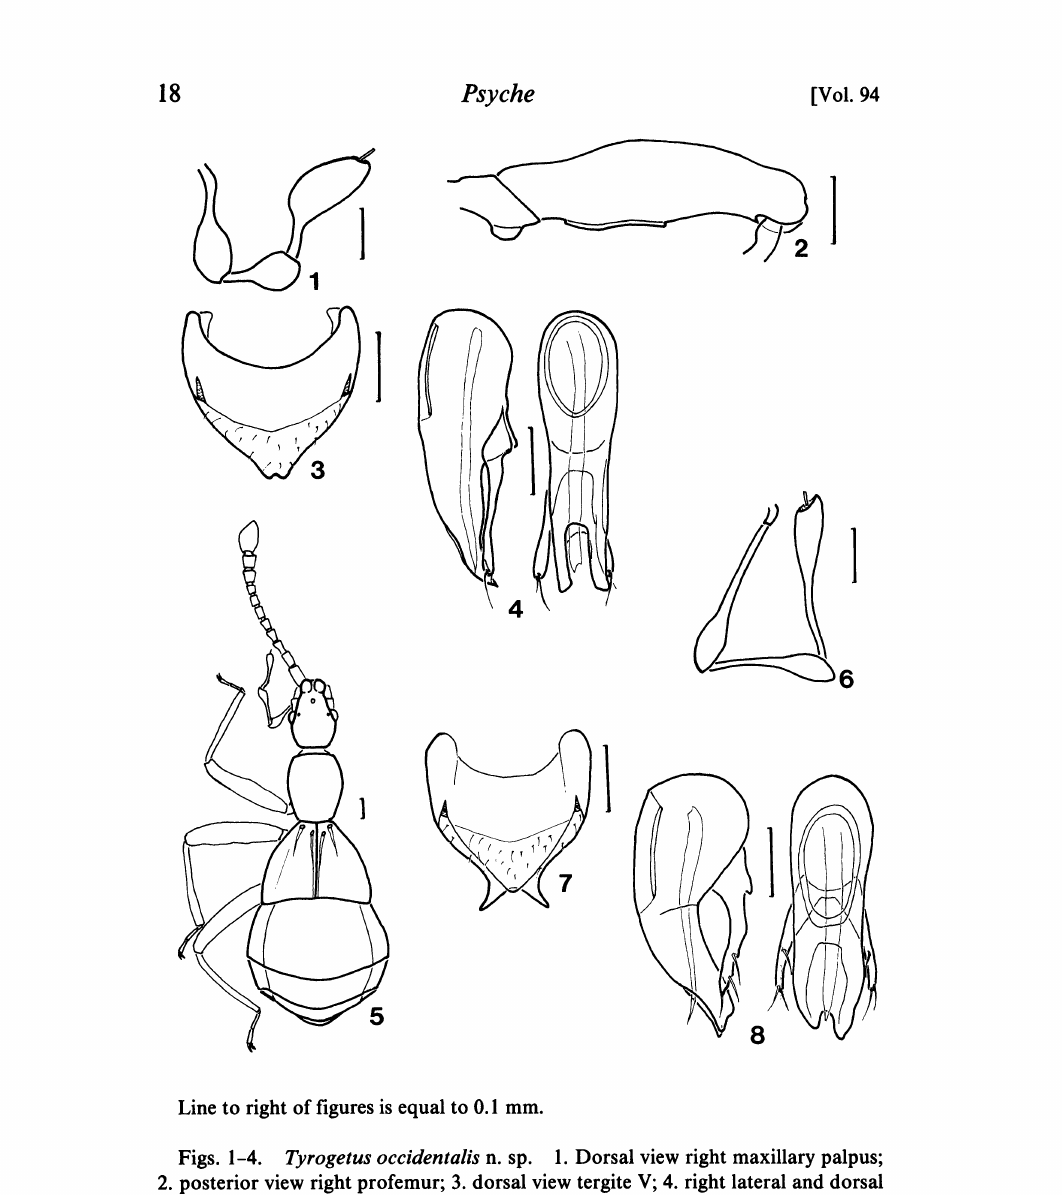
Line to right of figures is equal to 0.1 mm. Figs. 1-4. Tyrogetus occidentalis n. sp. 1. Dorsal view right maxillary palpus; 2. posterior view right profemur; 3. dorsal view tergite V; 4. right lateral and dorsal view male genitalia. Figs. 5-8. Tyrogetus howardi n. sp. 5. Dorsal habitus; 6. dorsal view right maxillary palpus; 7. dorsal view tergite V; 8. right lateral and dorsal view male